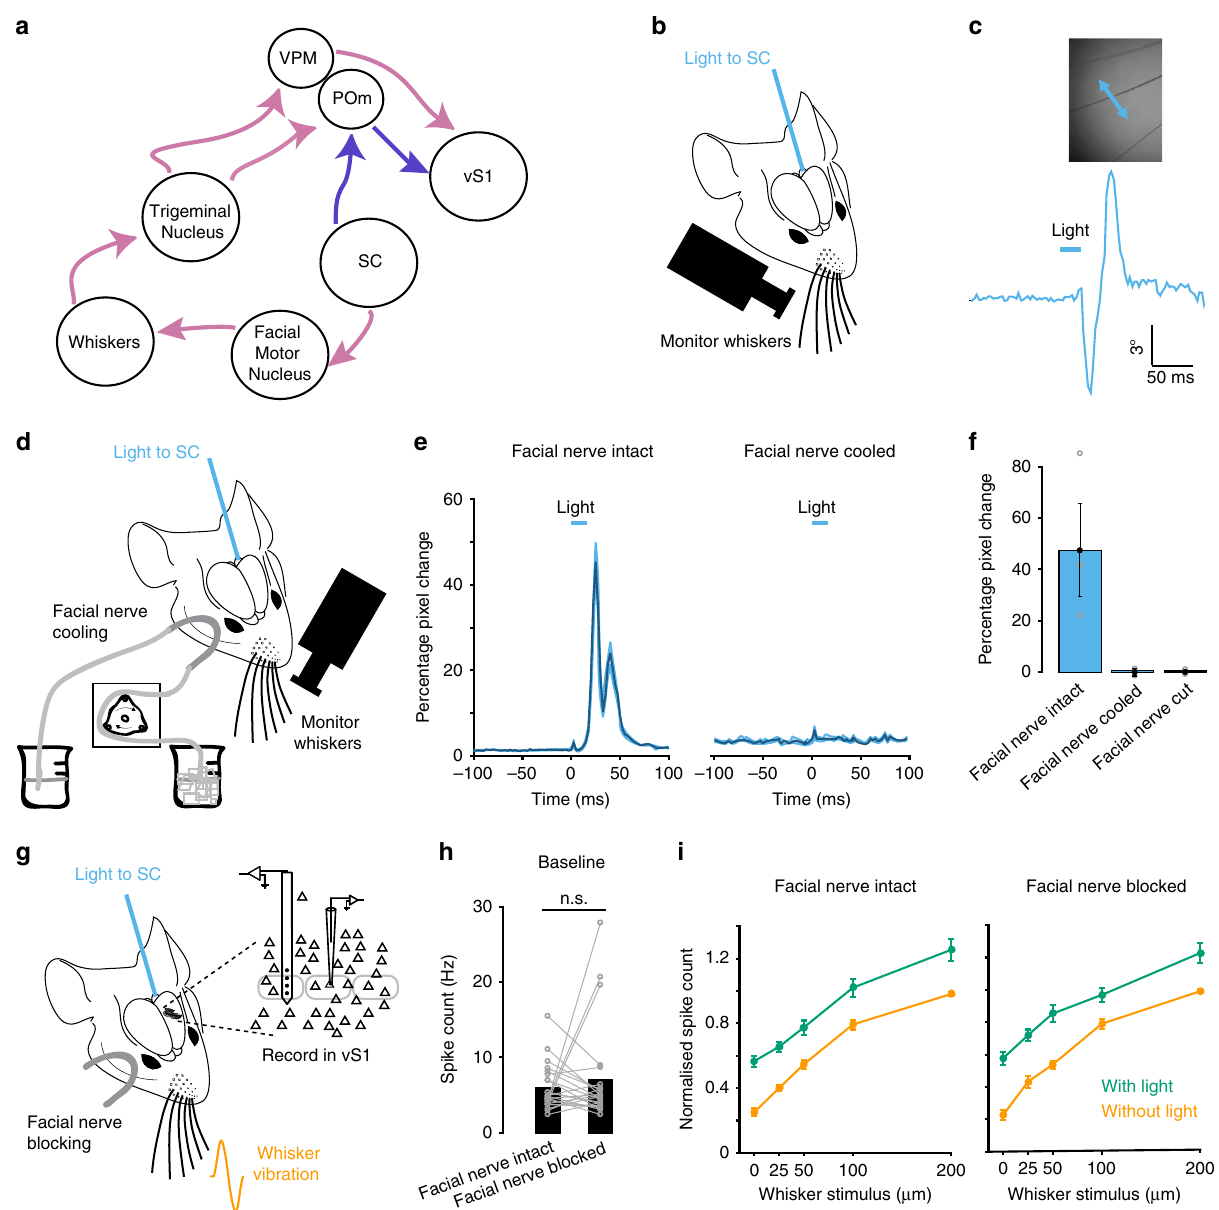
Fig. 3 Modulation of vS1 by SC is not due to whisker movement. a Circuits of interest showing two possible pathways through which SC could impact on responses in vS1. Modi fi ed from Castro-Alamancos and Keller 25 . b Schematic of the experimental arrangement using a high-speed camera to monitor whisker movement while activating SC optogenetically via an optic fi ber. c Whisker movement during optogenetic activation of SC. d Schematic of the experimental arrangement. Whiskers were monitored during optogenetic activation of SC before and during facial nerve cooling. e Pixel change in a region of interest around whiskers during optogenetic activation of SC versus time before and after facial nerve cooling. Dark blue shows the mean and light blue the SEM across 50 trials. f Mean whisker pixel change ( n = 3 animals) in response to optogenetic activation of SC before and after cutting or cooling the facial nerve. Error bars represent SEM. g Schematic of the experimental arrangement. The impact of optogenetic activation of SC on vS1 responses was measured before and after facial nerve block. h Baseline spiking of vS1 neurons does not signi fi cantly change after facial nerve inactivation ( p > 0.05 Two- sided paired t-test; facial nerve cooling: n = 16; facial nerve cut: n = 8). i Pooled data showing the impact of SC activation (green) on the whisker input – output relationship (orange) for whisker responsive vS1 neurons before and after facial nerve inactivation (facial nerve cooling: n = 16 neurons; facial nerve cut: n = 8 neurons). The spiking of each neuron was normalized to the maximum response to whisker stimulation alone. Error bars represent SEM. Source data are provided as a Source Data fi eYFP fl uorescence in POm (Fig. 6b, left) with light activation of these neurons leading to action potential generation ( n = 4; data not shown). eYFP fl uorescent axons were also found in vS1 (Fig. 6b, right). Whole-cell recordings from neurons in vS1 in vitro were used to determine if these POm axons provide functional input to vS1. Brief (2 ms) optogenetic activation of (Fig. 6a). Histological analyses revealed cell bodies expressing